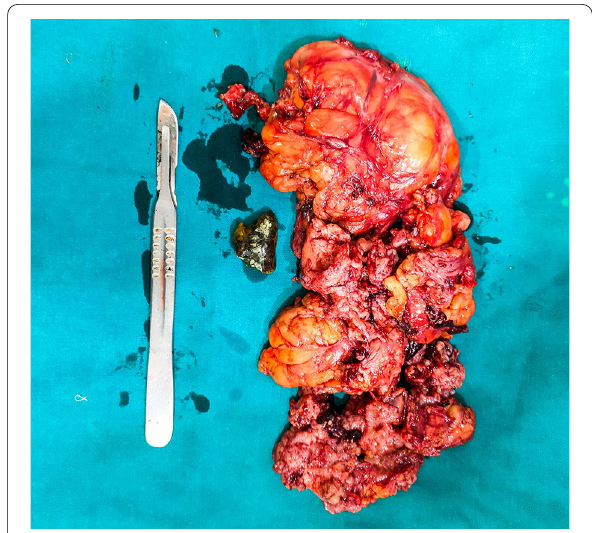
Figure 3 Kidney